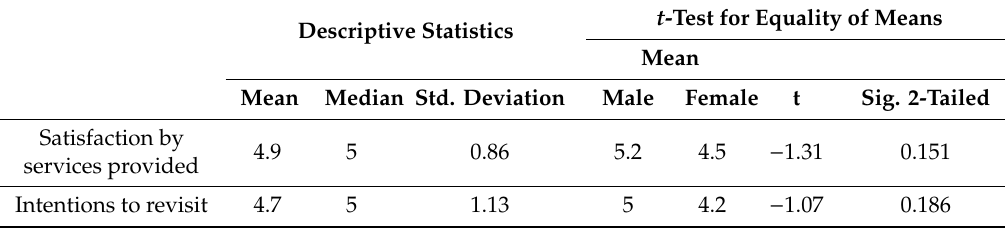
Table 3. Descriptive statistics and independent t -test results for endogenous